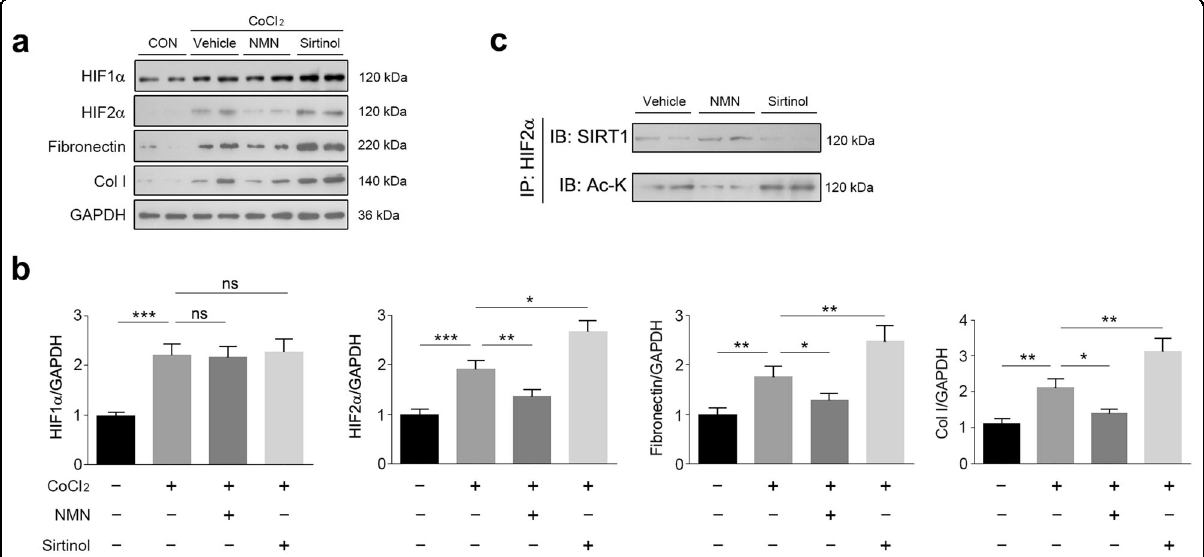
Fig. 7 Modulation of SIRT1 activity affects HIF-2 α and fi brosis gene expression. a NRK-49F cells were treated with CoCl 2 , NMN, Sirtinol as indicated. Cell lysates were prepared for western blot analysis. HIF-1 α , HIF-2 α , Fibronectin, and Col I were increased by inhibition of SIRT1. GAPDH was used as a loading control. b Quantitative analysis of western blot data as shown in a . c SIRT1 interacts with and deacetylates HIF-2 α . NRK-49F cells were treated with NMN, Sirtinol as indicated. Total cell lysates were prepared and subjected to co-immunoprecipitation analysis using an anti-HIF-2 α antibody. The immunocomplex was analyzed by western blot. IP: immunoprecipitation. IB: immunoblot. Data are means ± SEM. ns means no signi fi cance. * P > 0.05, ** P < 0.01, *** P <